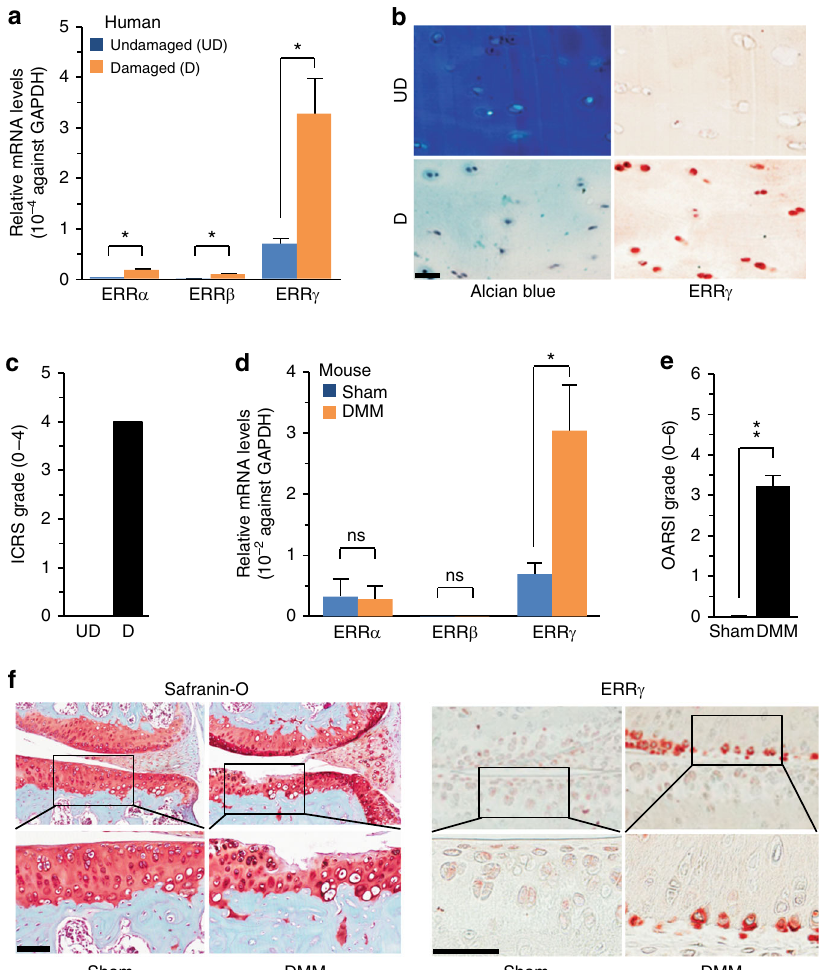
Fig. 1 ERR γ is upregulated in OA cartilage from humans and mouse models. a – c qRT-PCR analysis ( n = 11) was used to assess the mRNA expression levels of ERR isoforms in undamaged (UD) and damaged (D) regions of human OA cartilage ( a ). Representative images ( n = 10 patients) show alcian blue staining of sulfated proteoglycans and immunostaining of ERR γ in UD and D regions of human OA cartilage ( b ). ICRS (International Cartilage Repair Society) grade of human OA cartilage sourced from individuals undergoing arthroplasty ( c ). d – f ERR mRNA levels were quanti fi ed by qRT-PCR ( n = 10 mice per group) in cartilage tissues from mice subjected to sham operation or DMM surgery ( d ). Cartilage destruction was scored by OARSI grading ( e ). Representative images ( n = 12 mice per group) of safranin-O-stained and ERR γ -immunostained OA cartilage from DMM-operated mice or cartilage from sham-operated mice ( f ). Values are presented as means ± s.e.m. (* P < 0.01 and ** P < 0.001; ns, not signi fi cant). Two-tailed t test ( a , d ) and Mann – Whitney U test ( e ). Scale bar: 50 μ